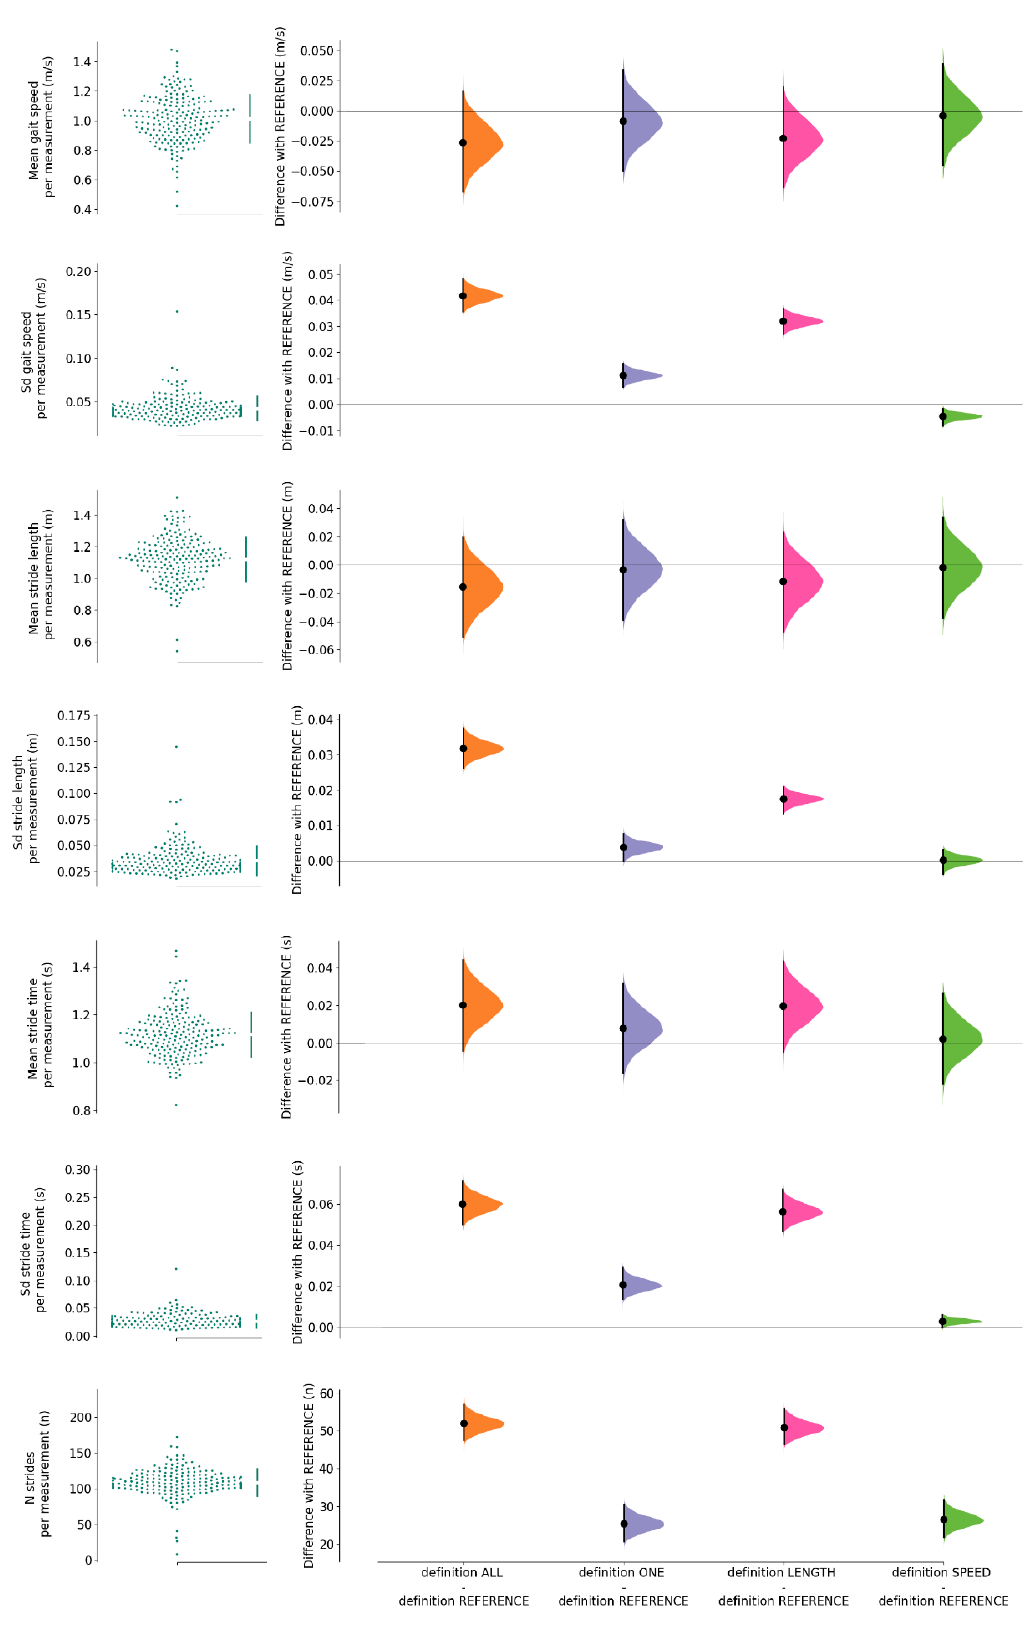
Figure 4. Scatterplot of means and SD of gait speed, stride length and stride time for definition REFERENCE , and the mean difference plots for each definition with REFERENCE , including the average number ± SD of selected strides per trial for each definition